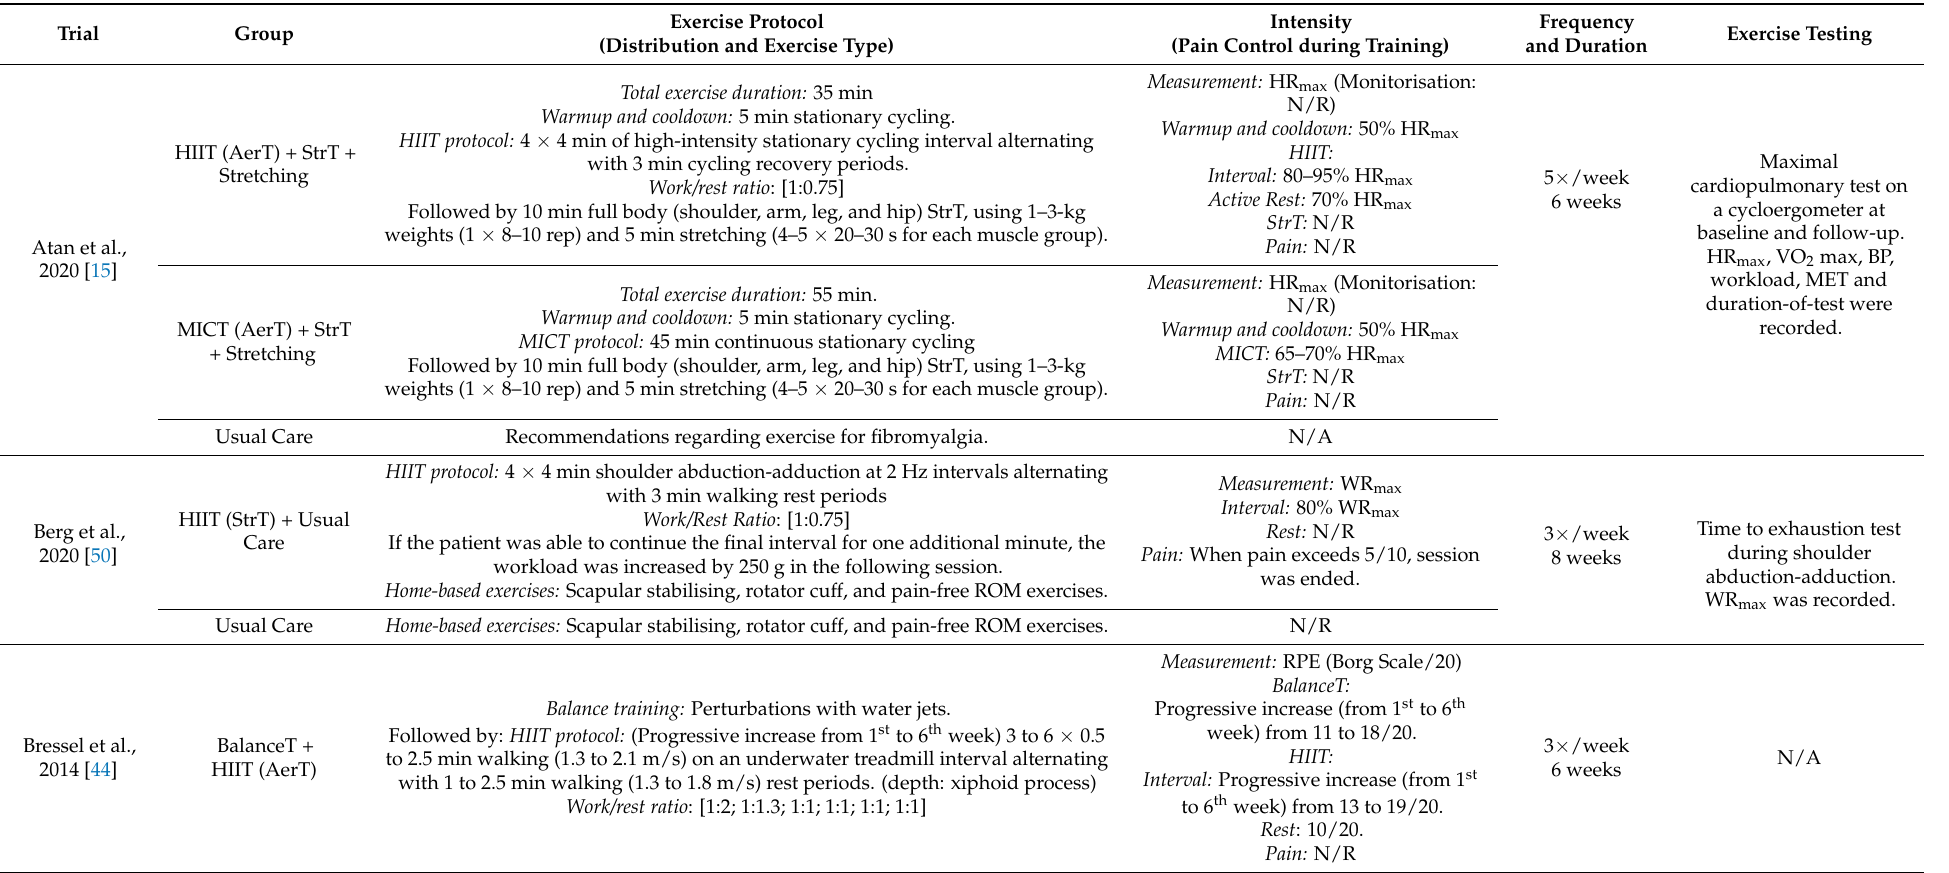
Table 2. Prescription parameters extracted from each included